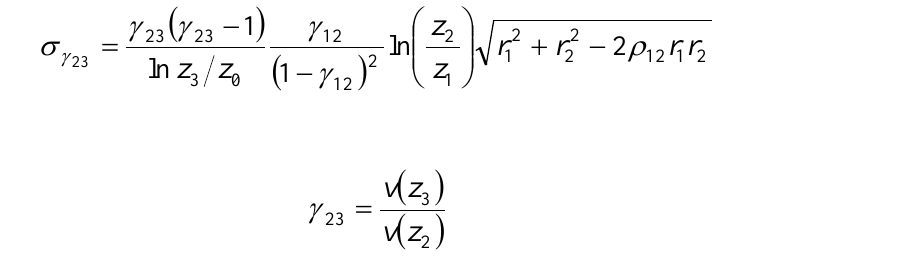
Figure 10. Relative error of the natural logarithm of the roughness length as a function of the natural logarithm of the true roughness length for different anemometer uncertainties and correlation